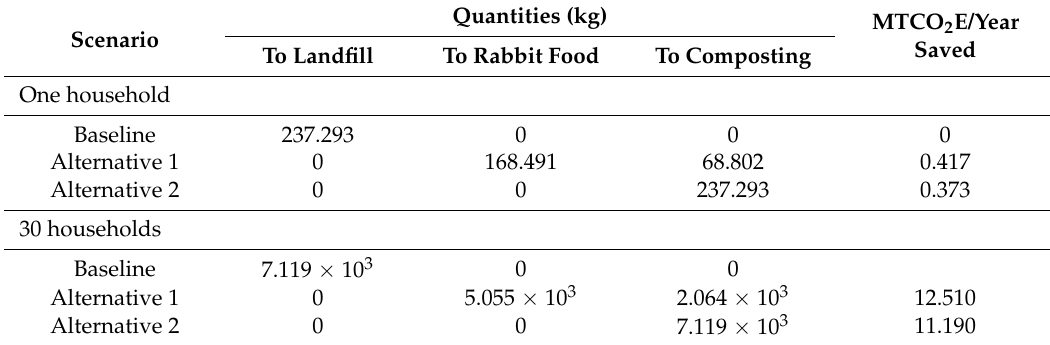
Table 2. CO 2 emissions avoided according to different scenarios.